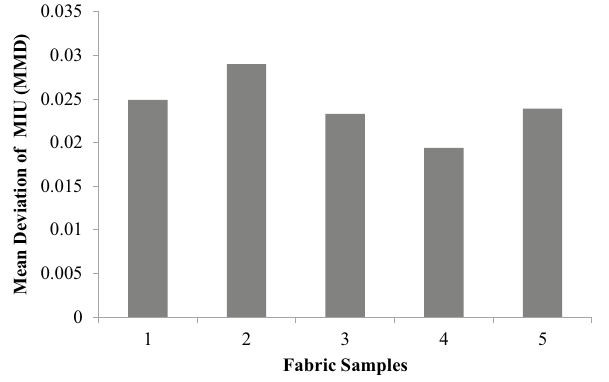
Figure 19. Mean deviation of MIU (MMD).